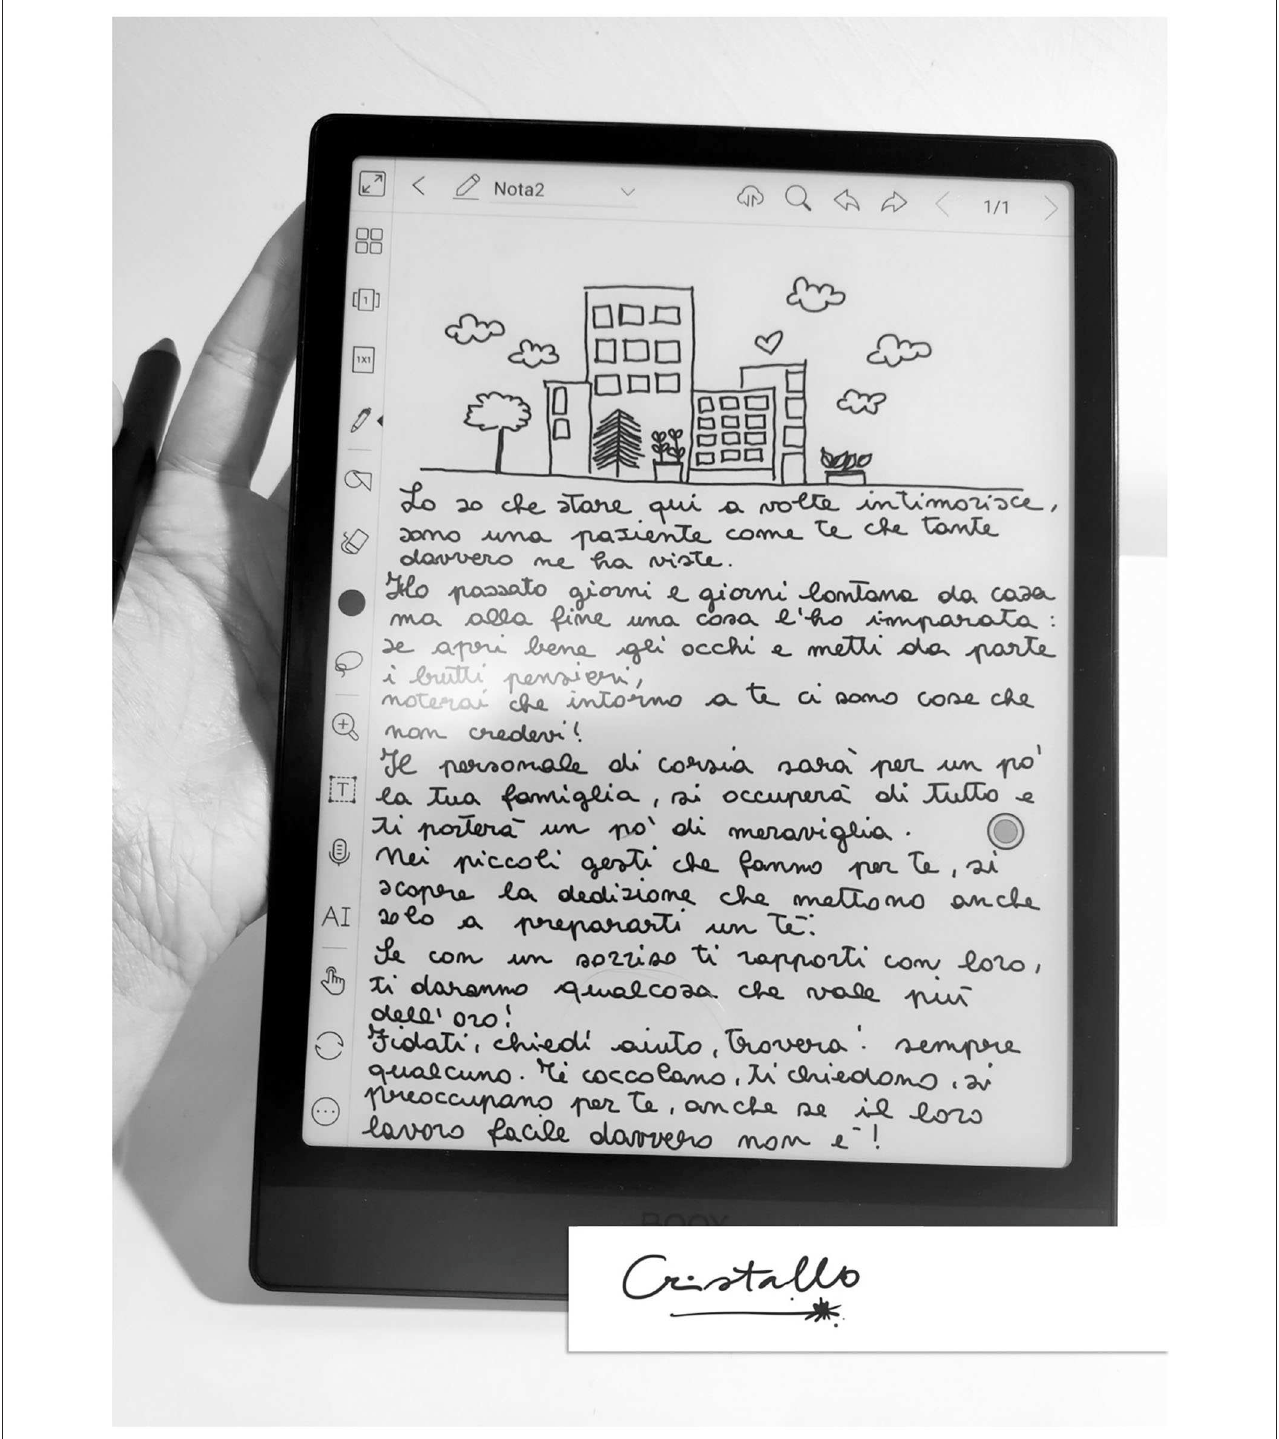
FIGURE7 A patient’s poem written on one of our Cristallo devices. Translation of the poem: “I know that being here is sometimes intimidating, I am a patient like you who has seen a lot. I spent days and days away from home, but in the end, I learned one thing: if you open your eyes wide and put aside your bad thoughts, you will notice that there are things around you that you did not believe! The ward staff will be your family for a while, they will take care of everything and bring you some wonder. In the small gestures they make for you, you will discover the dedication they put into even just making you a cup of tea. If you deal with them with a smile, they will give you something that is worth more than gold! Trust me, ask for help, you will always find someone. They pamper you, they ask you, they care for you even if their job is not at all